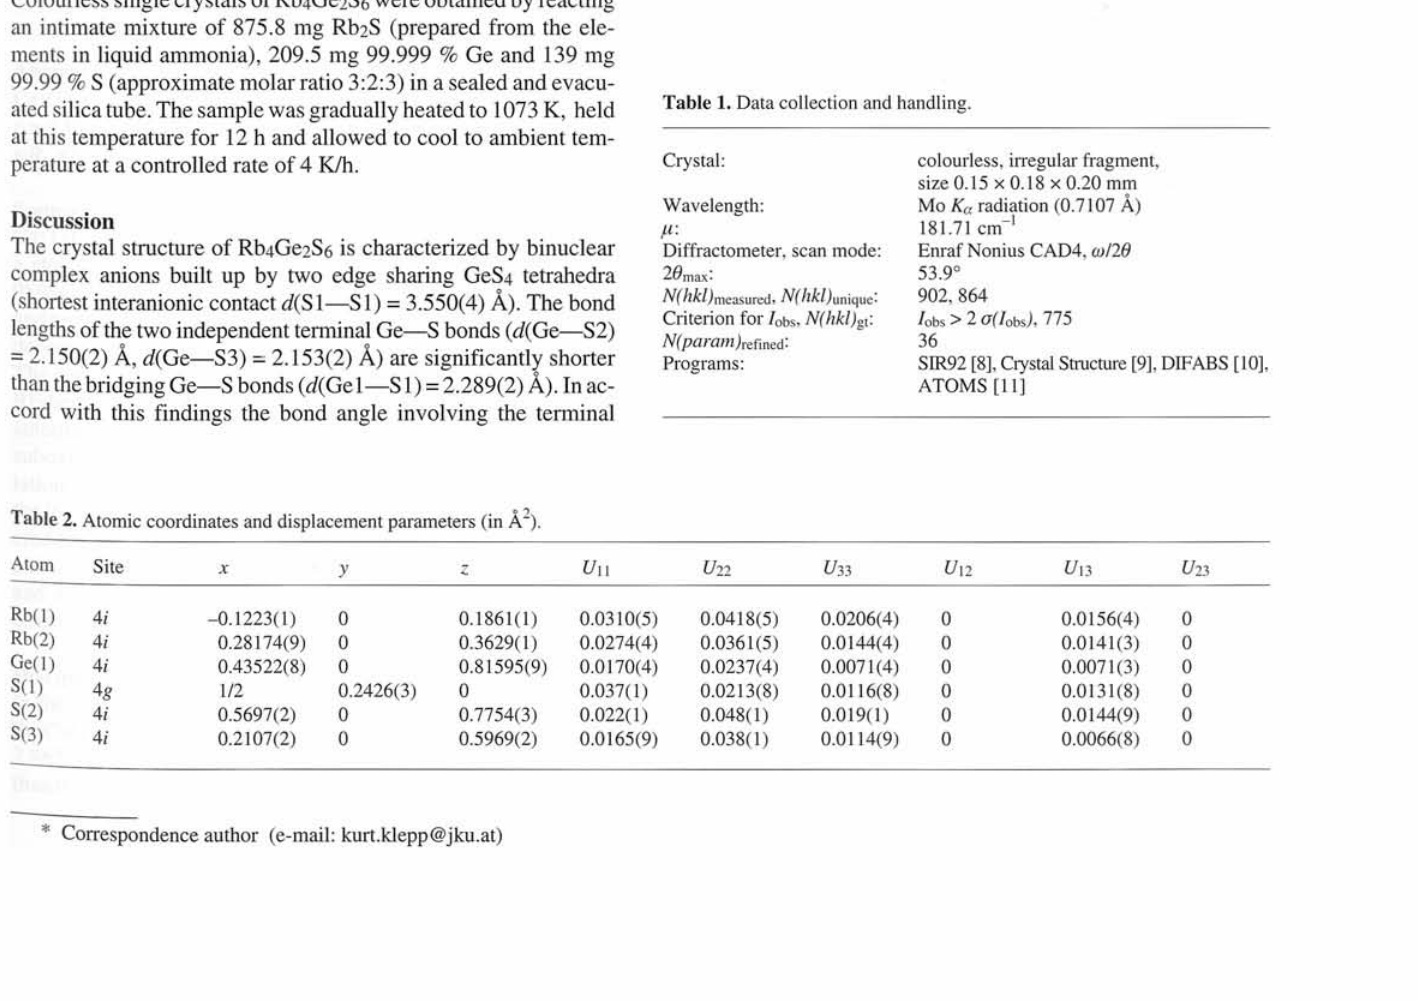
Table 1. Data collection and handling.